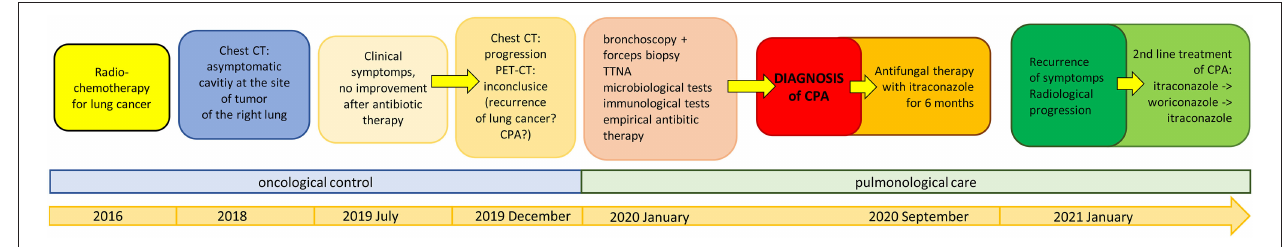
FIGURE 7 | A timeline with all relevant data from this clinical case.